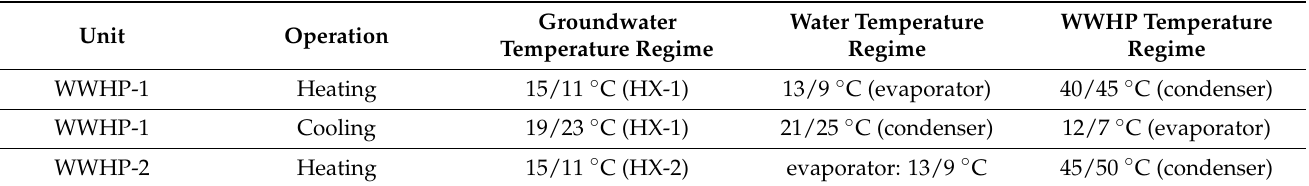
Table 2. Design temperature regimes for the equipment in WWHP system.